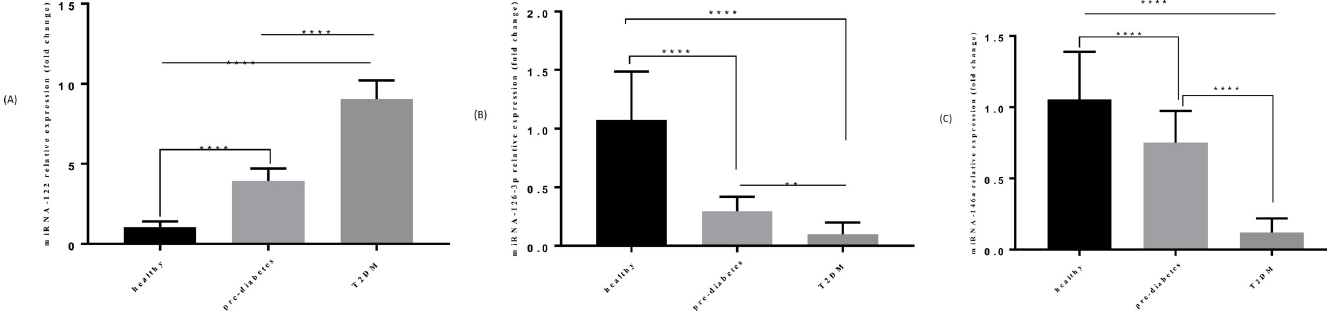
Fig 1. Comparison of expression levels of miRNA-122, miRNA-126-3p and miRNA-146a in T2DM (n = 30), pre-diabetic (n = 30) and control group (n = 30). A) Comparison of miRNA-122 expression level in 3 groups. B) Comparison of miRNA-126-3p expression level in 3 groups. C) Comparison of miRNA-146a expression level in 3